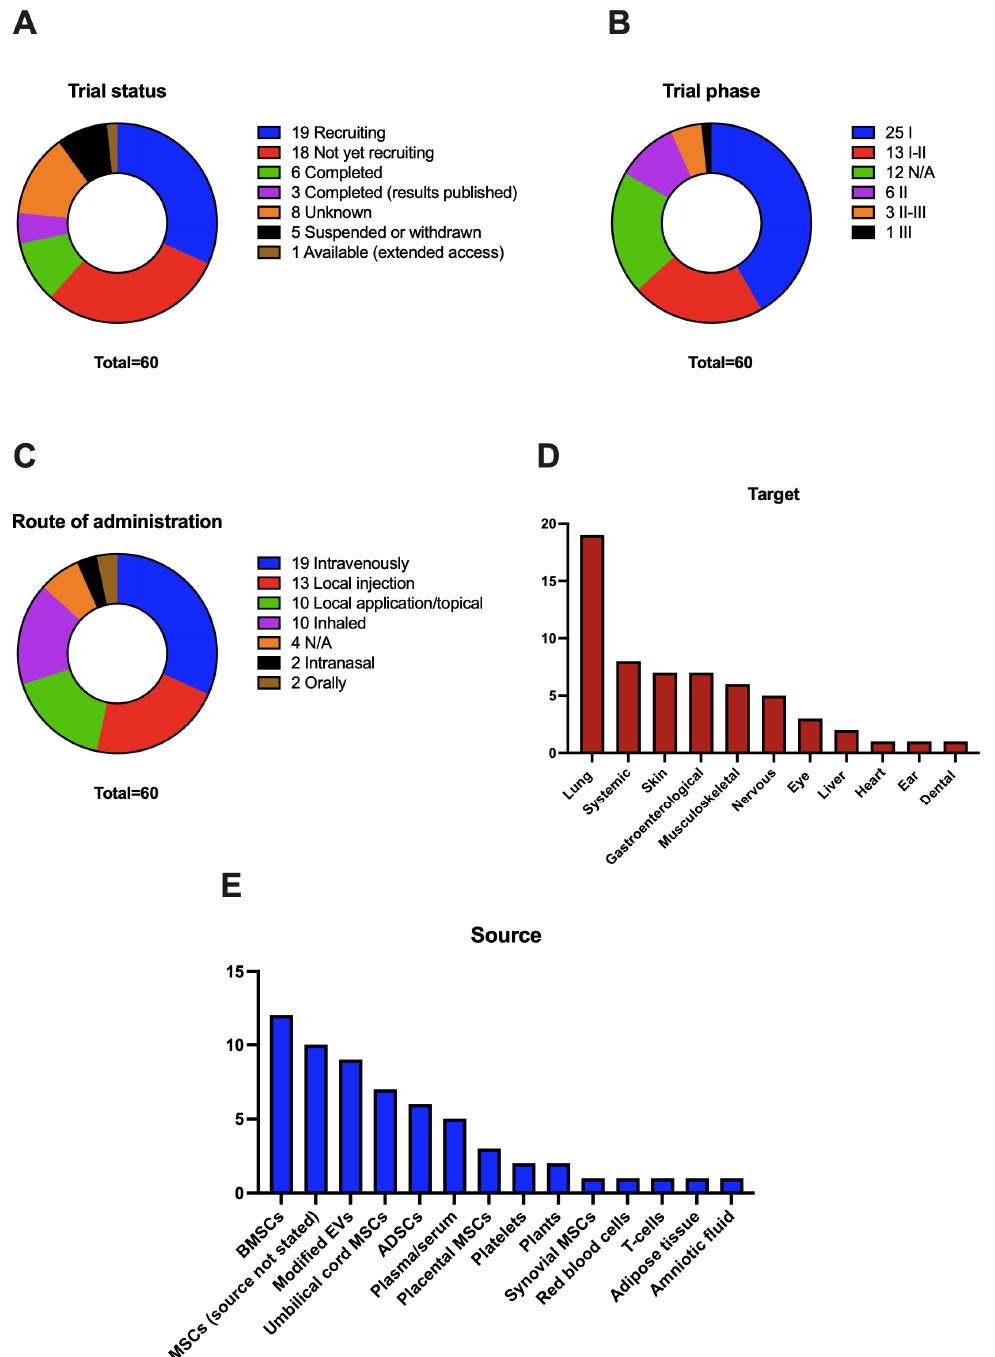
Figure 2. Graphical representation of the analysis of Table 1 results regarding ongoing and finalized clinical trials that use EVs therapy as the main intervention. ( A ): Trial status defined by clinical- trials.gov. ( B ): Trial phase defined by clinicaltrials.gov, when the phase is not available or is not applicable N/A is shown. ( C ): Route of administration of the EV preparation, when not stated N/A is shown. ( D ): Organs or systems related to the primary outcome measured in the trial. ( E ): Source of the EVs used in the trial.